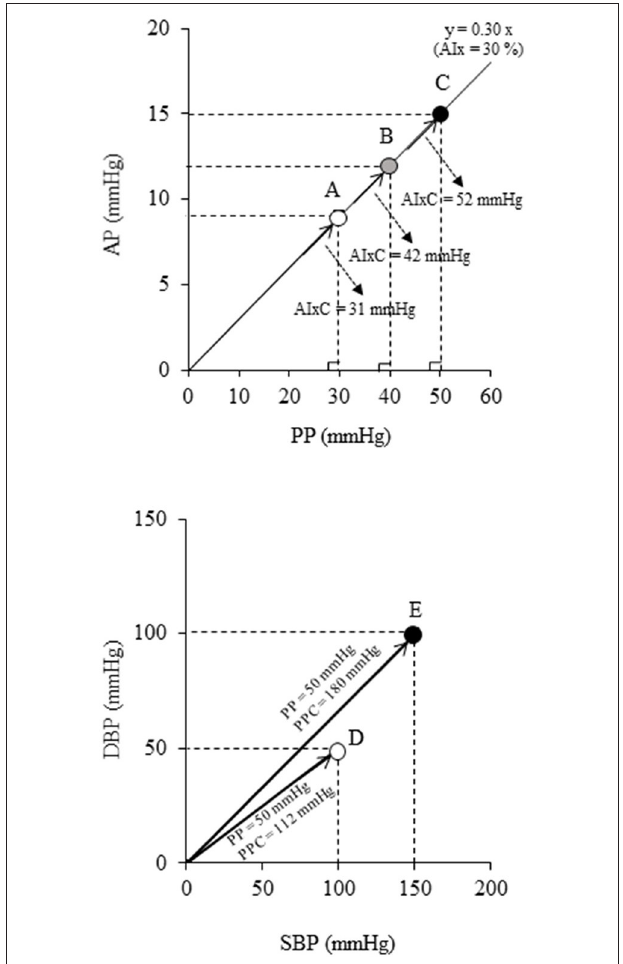
FIGURE 1 | Schematic diagrams indicating the limitation of the conventional ratio-based and difference-based metrics: (Top) augmentation index (AIx) and (Bottom) pulse pressure (PP). These indices have various physiological loads even at the same values (e.g., points A-C all have AIx have PP 50 mmHg). Companions of AIx (AIxC = (PPC DBP 2 }) are alternative data representation obtained by the √ {SBP 2 = + polar coordinate description which permits more precise characterization of individuals